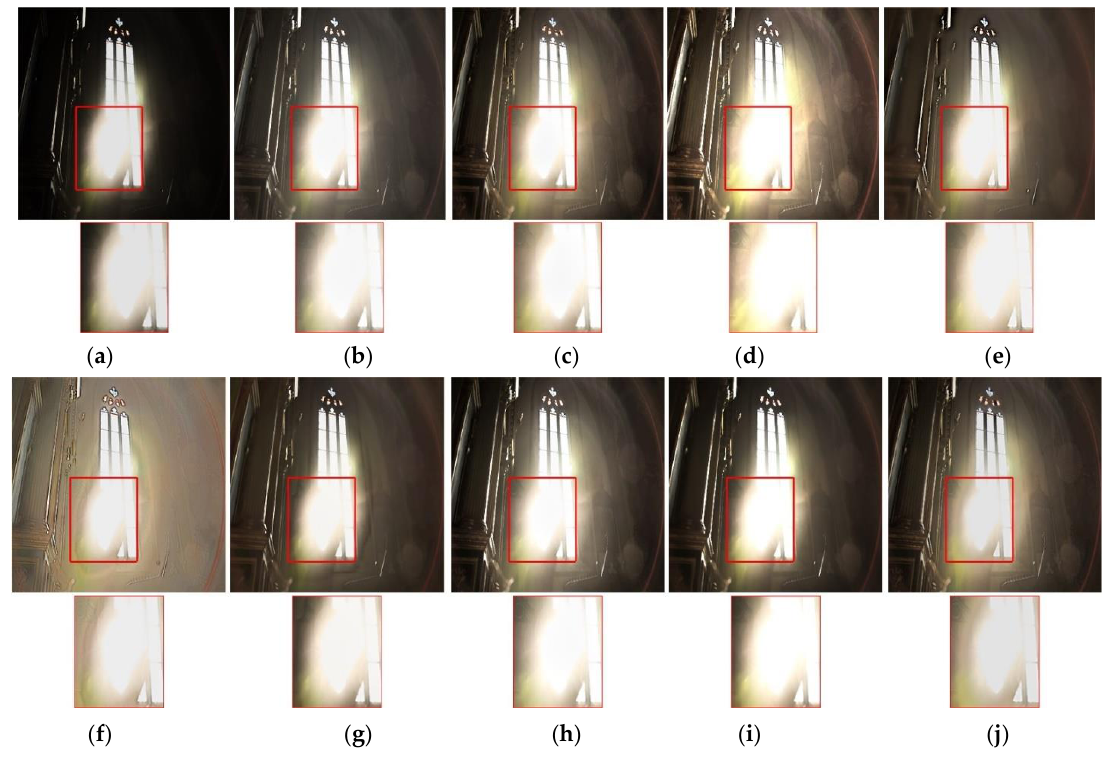
Figure 21. Enhanced results of “Hand” image. ( a ) Original image; ( b ) BIMEF; ( c ) MEF; ( d ) LIME; ( e )